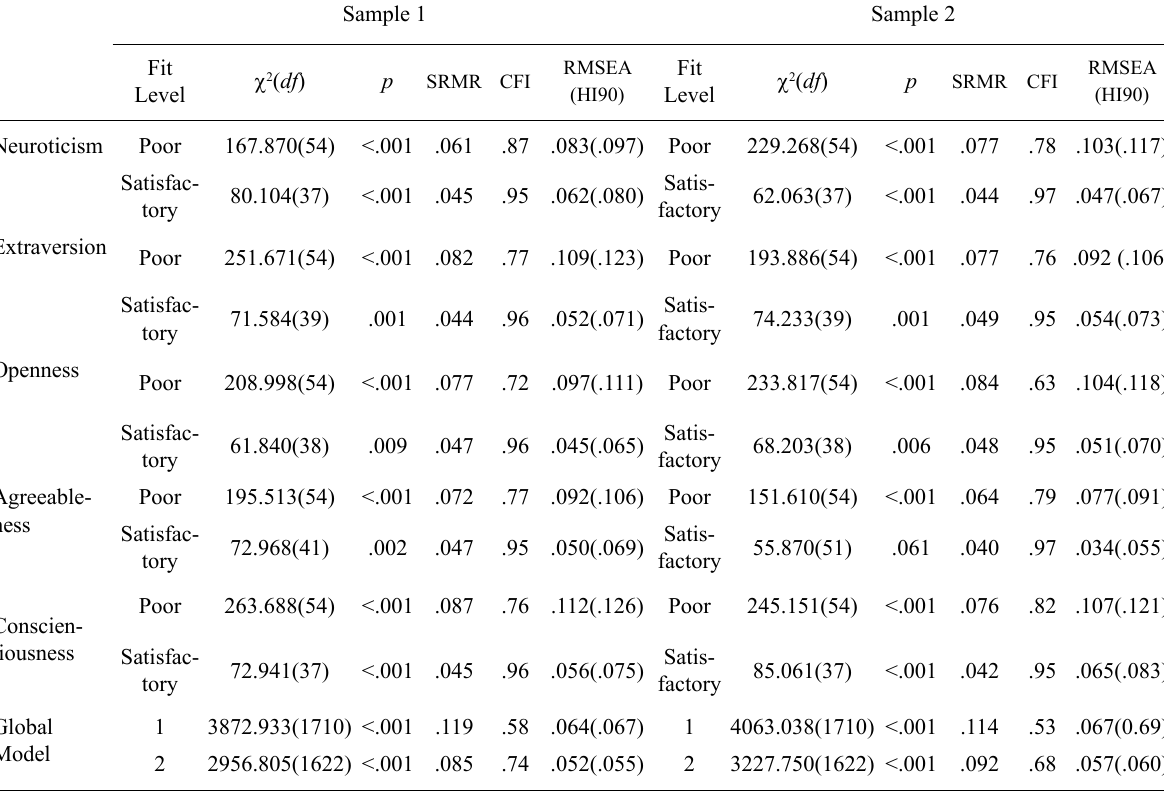
Summary of Maximum Likelihood Model Fit